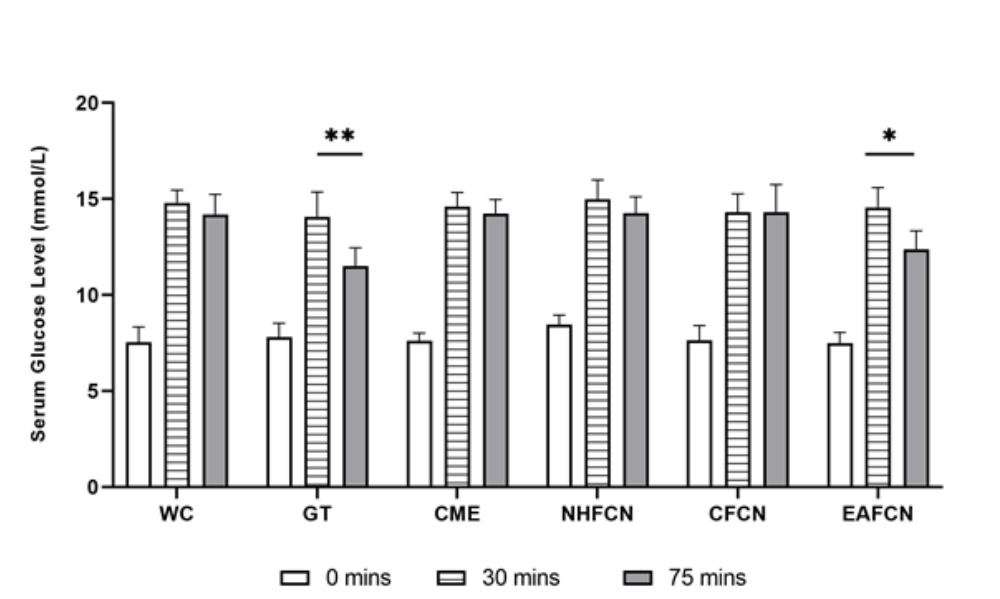
Fig. 2. Acute effects of cocos nucifera extracts on serum glucose level of type II diabetic rats with a simultaneous glucose load. Glucose levels were measured at 0 min, 30 mins, and 75 mins intervals in different treatment groups. Results are expressed as Mean ± SD. WC: Water control group; GT: Glibenclamide group; CME: crude methanolic extract; NHFCN: n-hexane fraction; CFCN: chloroform fraction and EAFCN: ethyl acetate fraction of cocos nucifera. P <0.05 compared to 30 mins level.